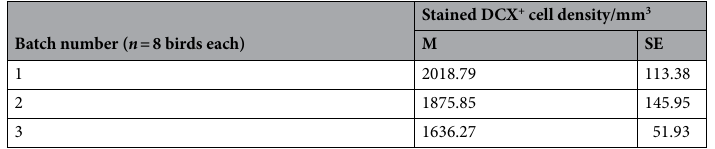
Table 2. Mean (M) and standard error (SE) for estimated densities of doublecortin (DCX) + cells of all types (combined multipolar and bipolar morphologies) stained over the whole HF of the 14-week-old laying hen pullets in each of the 3 immunohistochemistry processing batches (balanced for strain), reflecting technical variation.